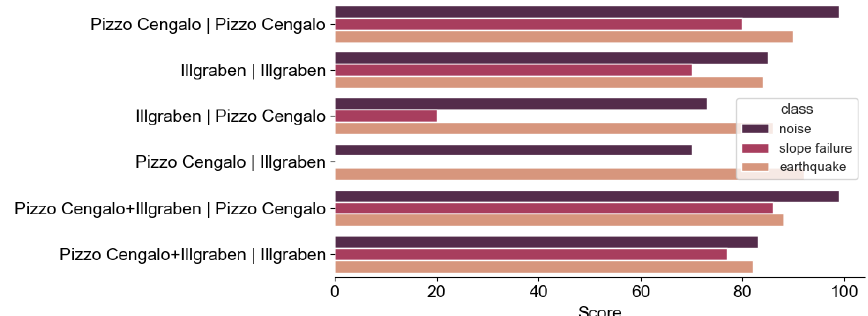
Figure 11. Scores for each class with different training and testing data sets. Labels on the y axis show the data set(s) used for training before the vertical bar and the data set used for testing after the vertical